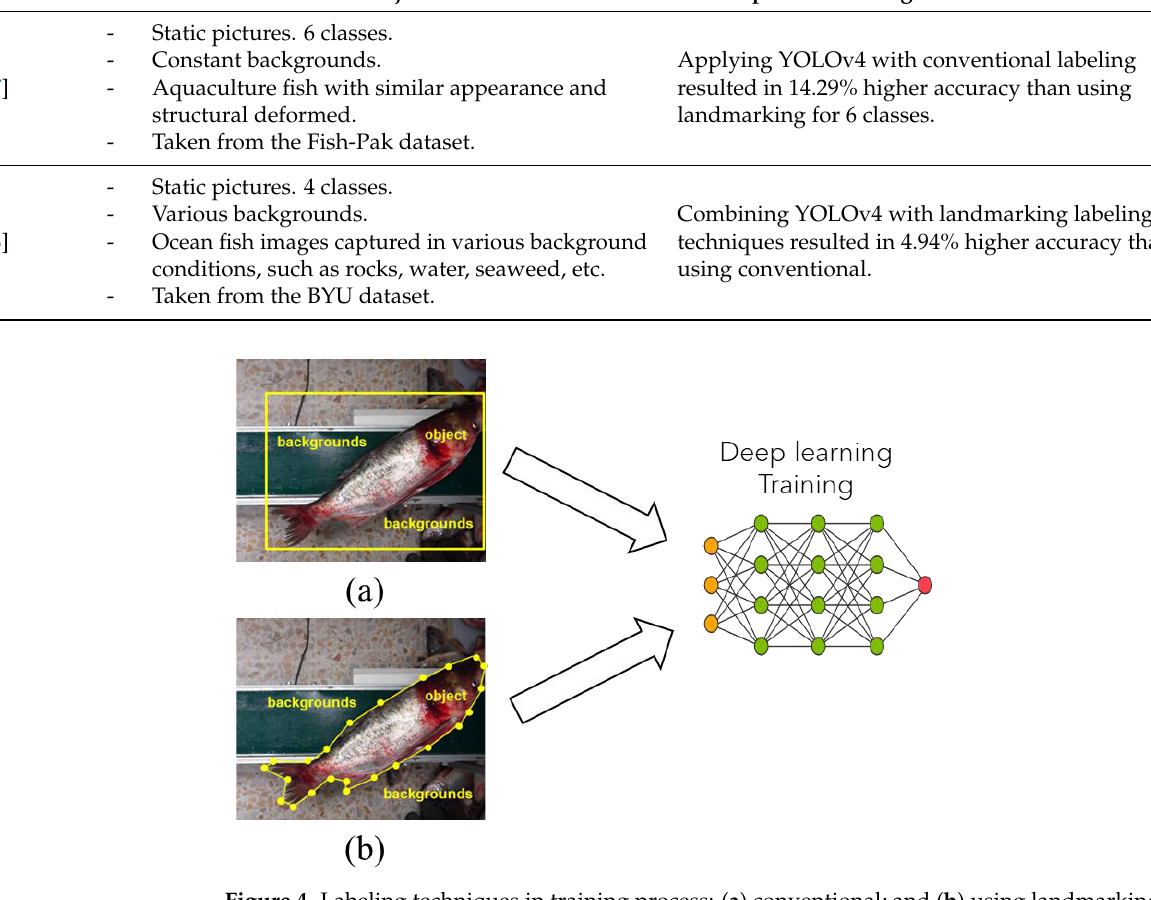
Figure 4. Labeling techniques in training process: ( a ) conventional; and ( b ) using landmarking. Table 4. Summary of recent works by authors that are related to this work.